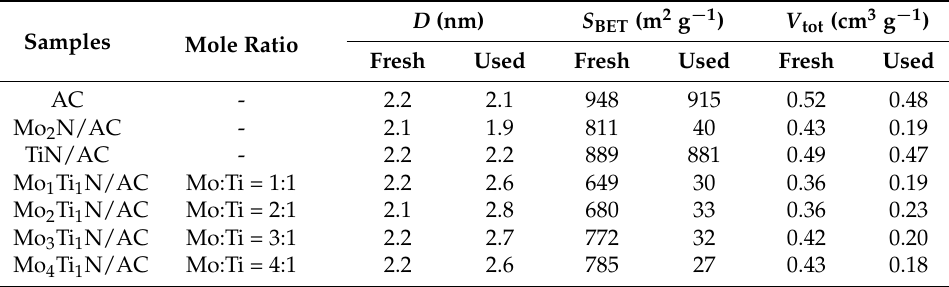
Table 1. Detailed synthetic ratio and the physicochemical